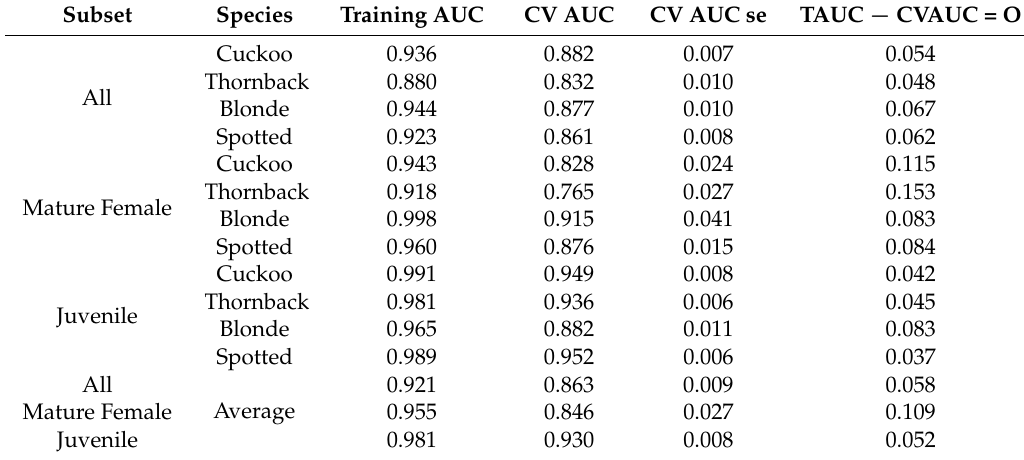
Table 2. Model performance scores. Training data Area Under Curve (AUC), Cross-Validated (CV) AUC (higher is better for both), CV AUC standard error, and training data AUC minus CV AUC (overfitting (O); lower is better for both). For the original full dataset, mature females, juveniles, and the averages of each. AUC values over 0.8 are very good, and over 0.9 excellent [31,32].